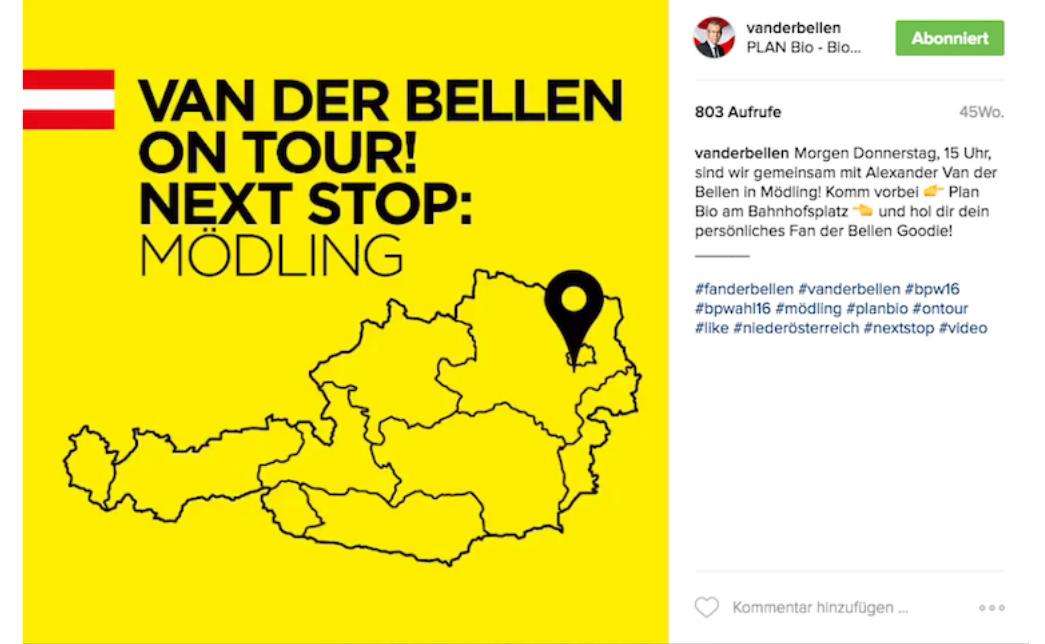
Figure 1. Van der Bellen on tour, posted on 6 April